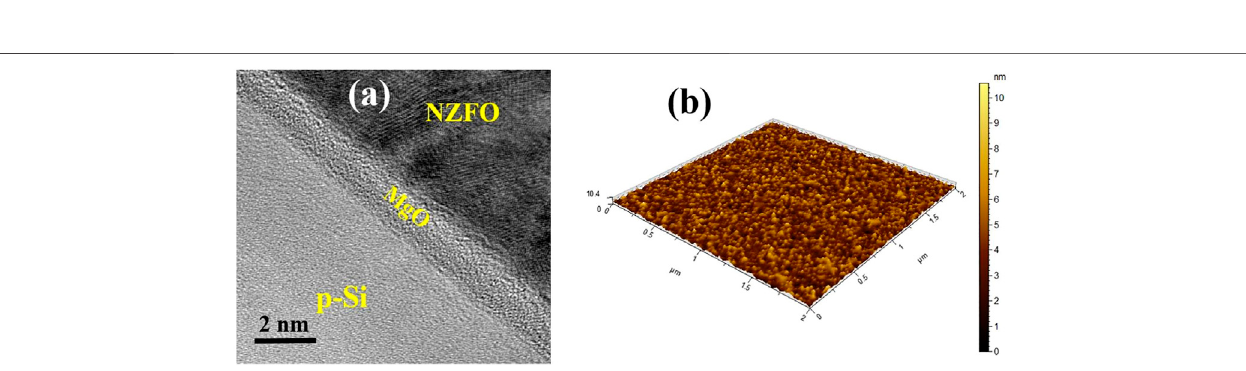
FIGURE 2 | (A) High-resolution TEM image (crosssectional view) of the NZFO/MgO/p-Si heterojunction. (B) 3-D AFM image of the NZFO thin fi lm.